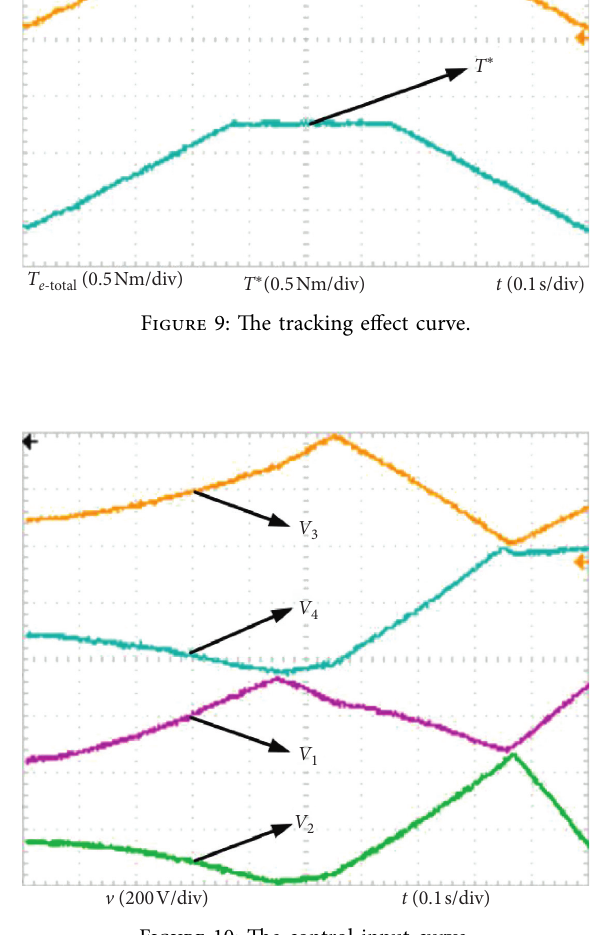
Figure 10: The control input